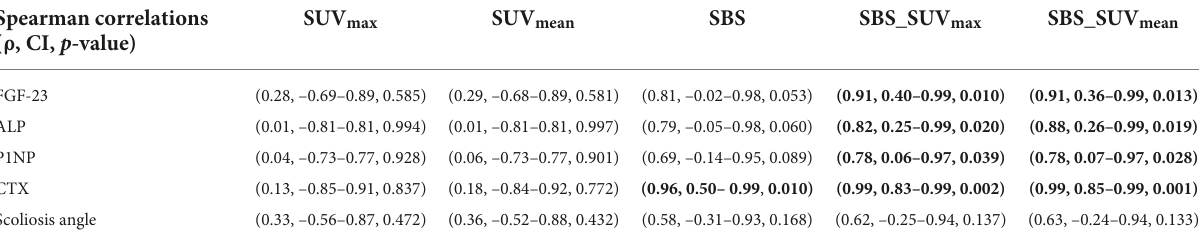
TABLE 2 Correlations between bone scintigraphy quantitative measures and biological bone turnover markers of disease activity and scoliosis angle. Spearman correlations ( ρ , CI, p -value)